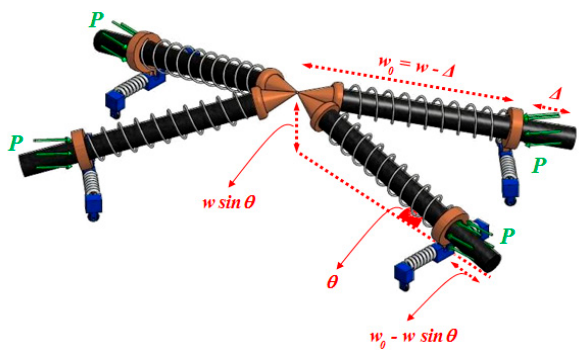
Figure 10. The PWCPE structure in an imaginary deviated mode; note that the P forces remain in the original directions.